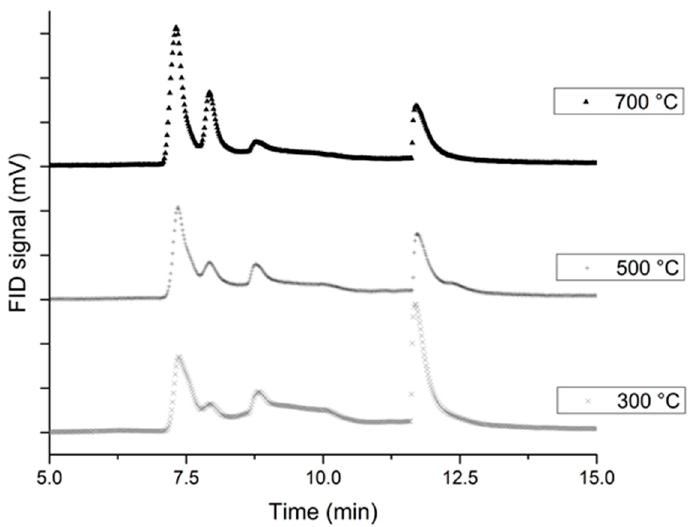
Figure 4. GC chromatographs regarding the probe temperature for the 85-15 propellant.